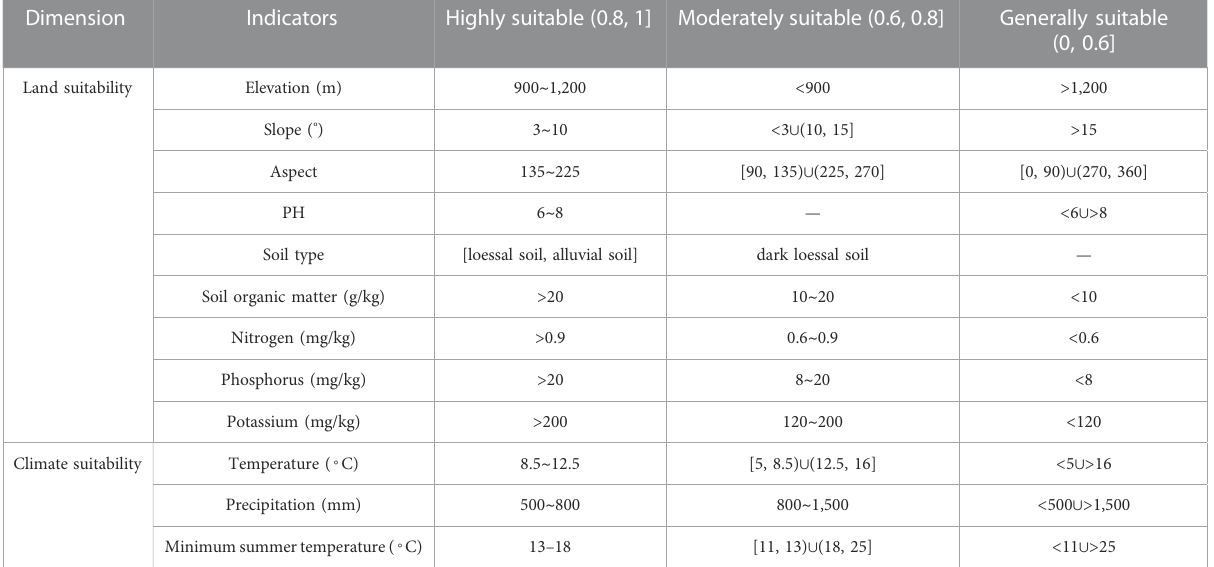
TABLE 4 The evaluation indicators system for orchard planting